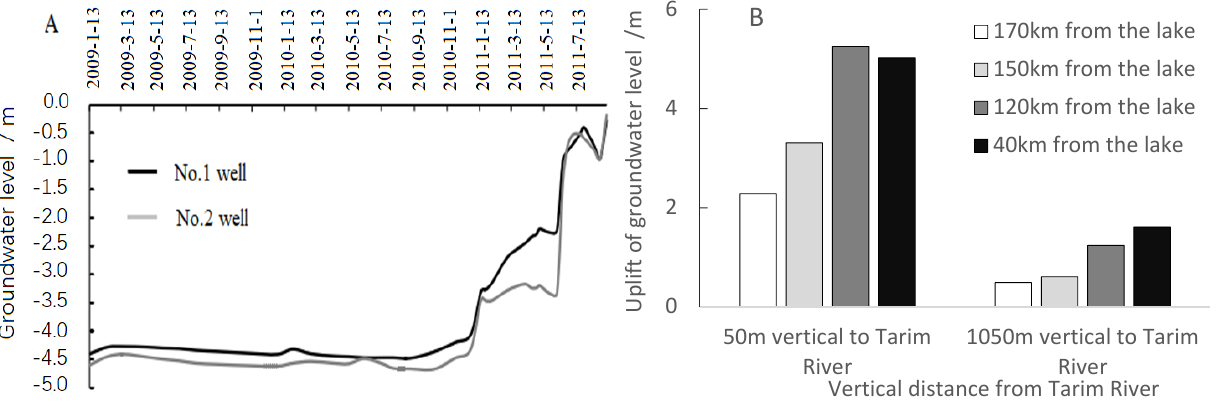
Figure 5. Groundwater level change around Taitema Lake ( A ) and at different distances from the lake ( B ).